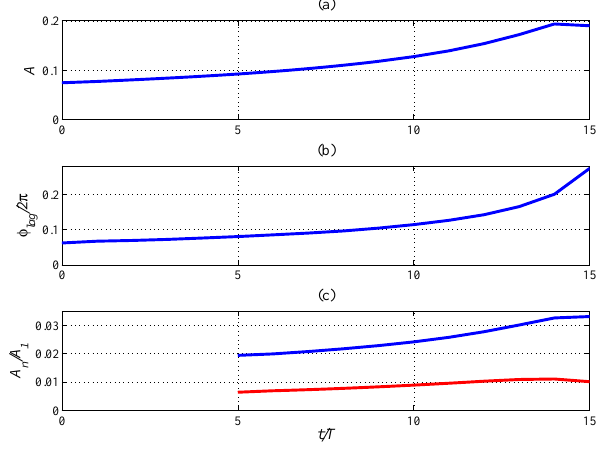
Figure 2. The dynamics of the system are described by Eq. (11) with varying D m . Parameters are set to D a = 1 / 2, T = π (the same order as the system timescale ωτ ∼ 1) and D m is varied linearly with time between -2 and 2 over about 25 cycles. In the upper panel the black lines are the nullclines while the system response is the blue line plotted against D ( t ). The orbit loses stability around a mean value of D ≈ 0 . 5 and jumps to a new orbit. In the lower panel we have plotted the system response (blue) against the forcing D against t/T . One can see the loss of stability of the orbit around t/T ≈ 15 and the prior increase in system response amplitude.